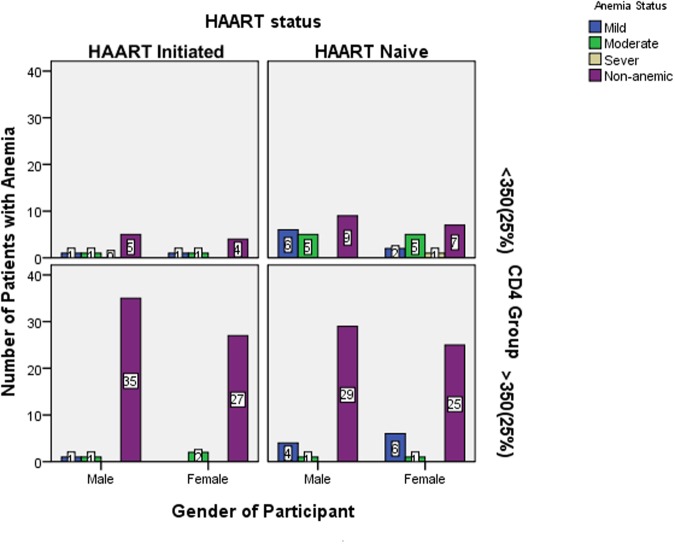
Distribution of anemia status/category with HAART status, CD4+ T cell category and gender among HAART initiated and HAART naïve pediatric HIV patients in ZMH from August 05, 2013 to November 25, 2013, Addis Ababa, Ethiopia.